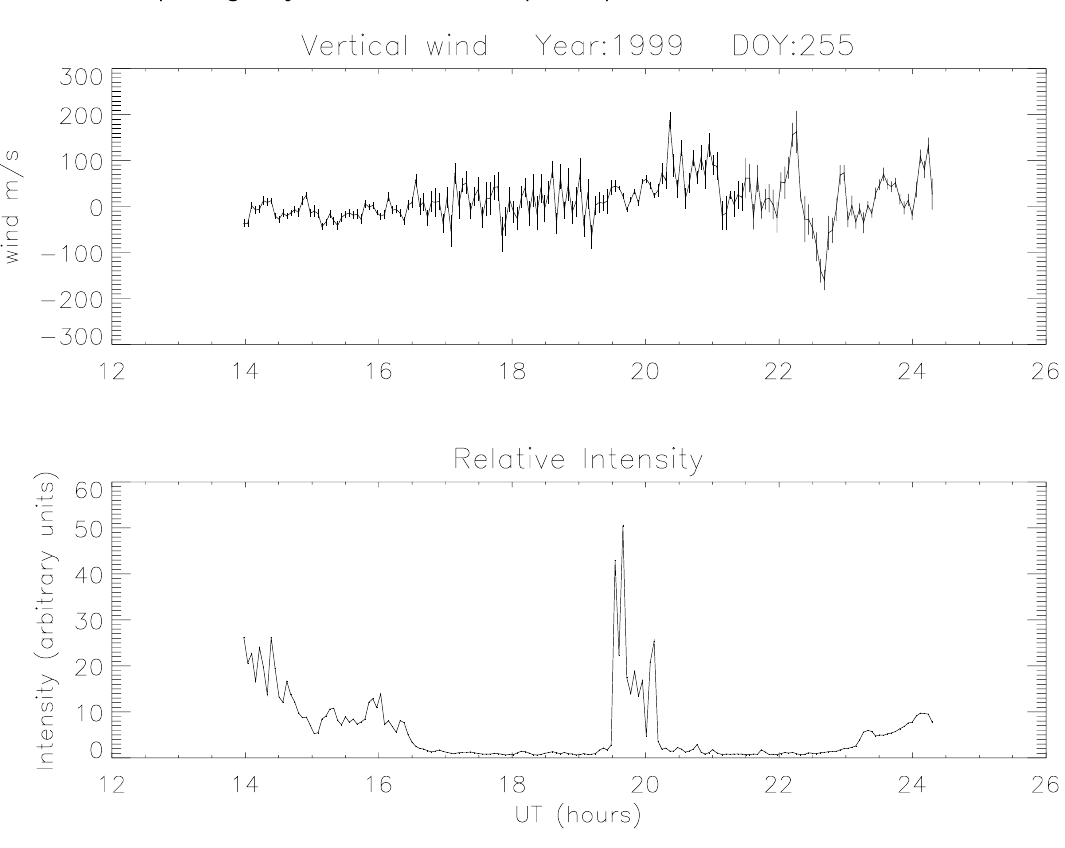
Fig. 1. FPS λ 630 nm data of wind and relative intensity from DoY